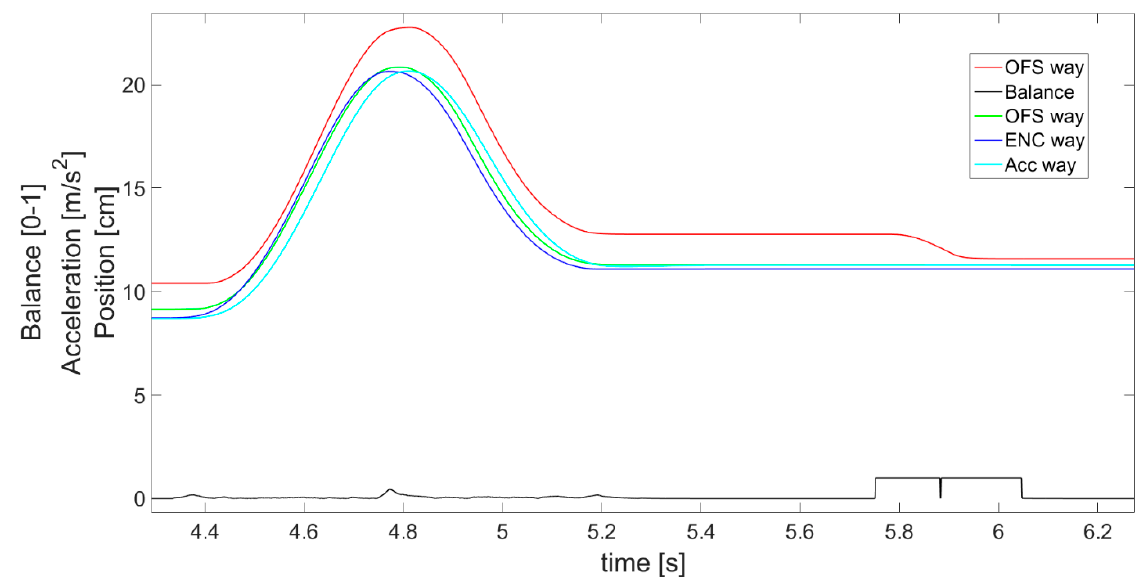
Figure 19. Magnified view of part of Figure 18, presenting a close comparison of displacements.